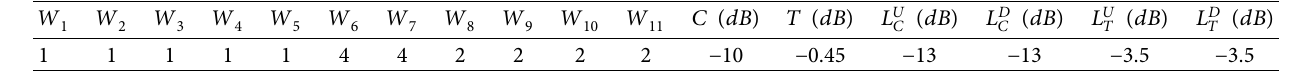
Table 7: Values of (9) for design 10dB ATRD coupler has been described in Example 3. W 1